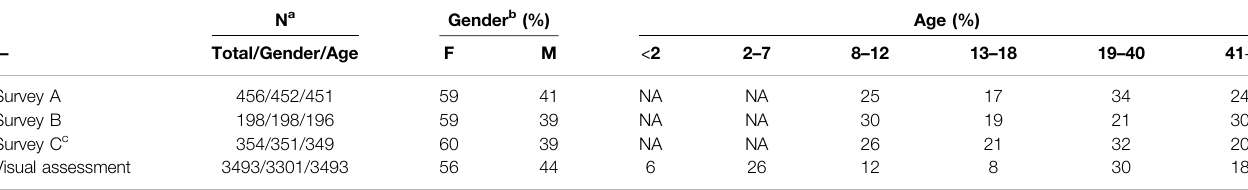
TABLE 3 | Percentage demographic comparisons of survey respondents, and general visitors visually assessed. N a Gender b